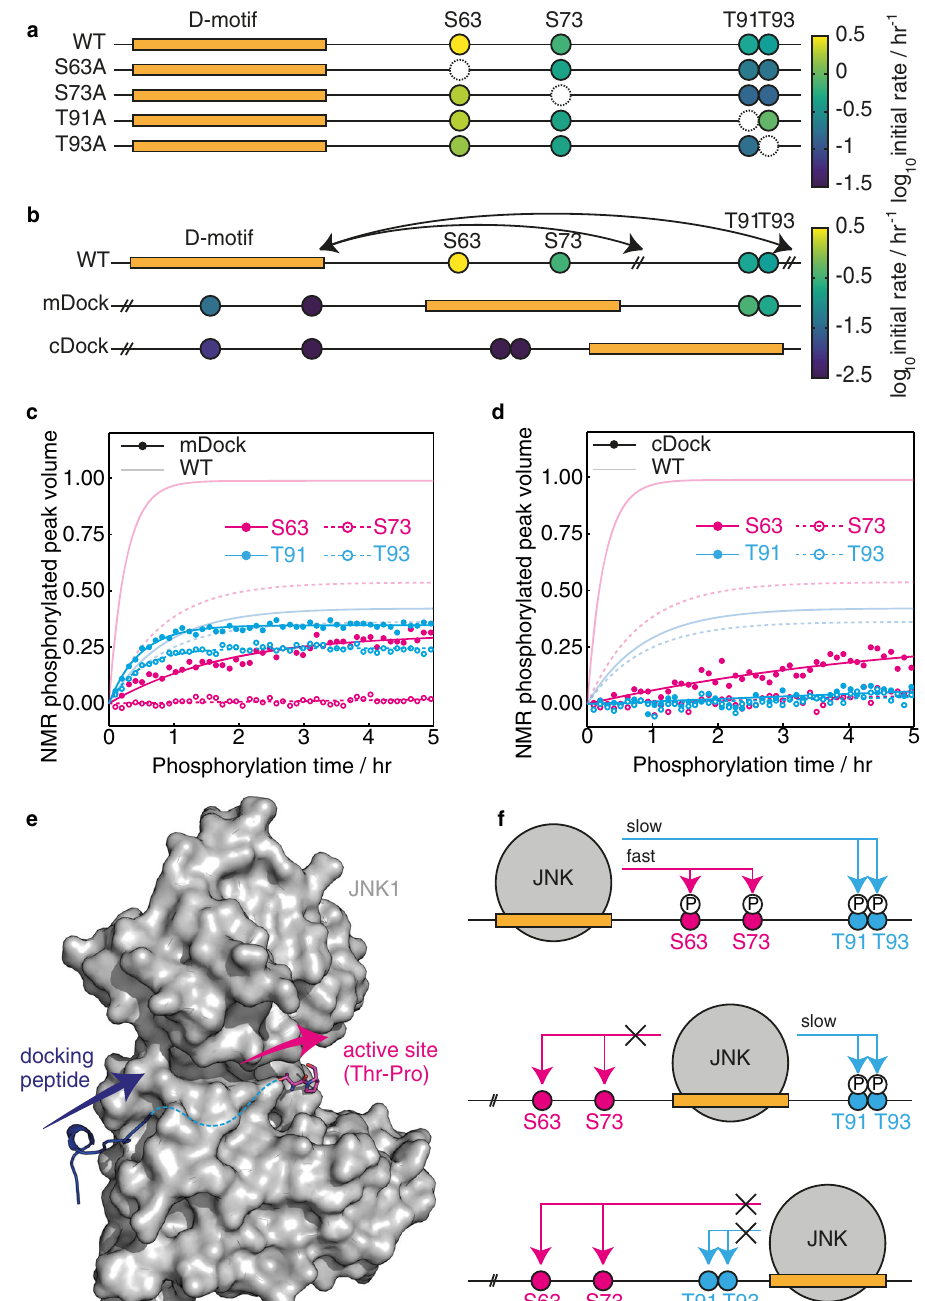
Fig. 3 | Effect of relative distance and orientation of the S/T-P sites from the D-motif on the c-JUN TAD N-terminal progressive multisite phosphorylation. a , b Schematic representation of the c-JUN TAD constructs S63A, S73A, T91A and T93A( a ),andmDockandcDock( b )comparingtowild-type(WT).Theinitialrateof phosphorylation of residues by JNK1, determined by time-resolved NMR spectro- scopy, is indicated according to the displayed colour scale. c , d Site-speci fi c build- up curves of the phosphorylation of c-JUN mDock ( c ) and cDock ( d ) variants by JNK1, showing the mean of two biologically independent samples and fi tted to single exponential build-up curves; pale lines show fi ts of wild-type c-JUN TAD